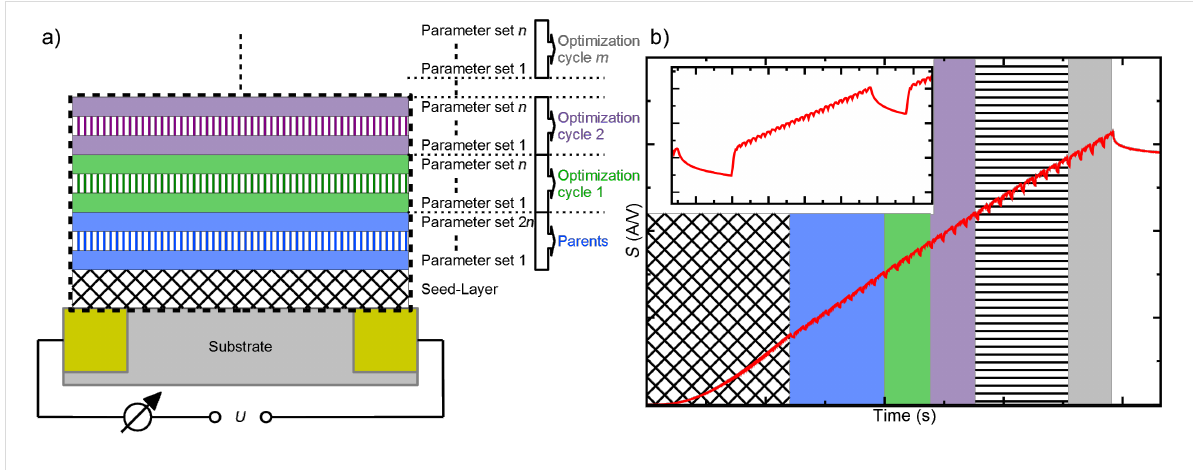
Figure 1: Schematic representation of the optimization process: (a) Layer structure of FEBID deposits: m optimization cycles, each consisting of n parameter sets except for the parent optimization cycle with 2 n parameter sets, are deposited onto a seed-layer between two Cr/Au electrodes. During the deposition process the conductance of the whole layer structure is measured. (b) Representative S ( t )-graph for the layer structure of (a). Altering background colors indicate the deposition of different optimization cycles. The inset depicts S ( t ) during the deposition of one layer. The S ( t )- curve shows a sharp increase when the FEBID process is started and decreases when the deposition process is stopped, respectively.